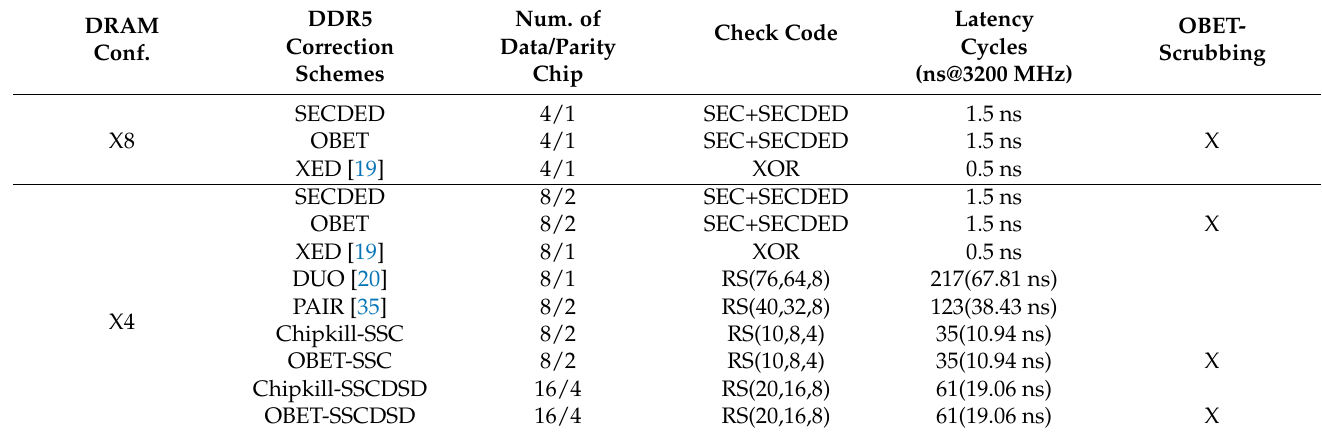
Table 1. DDR5 correction schemes per channel.